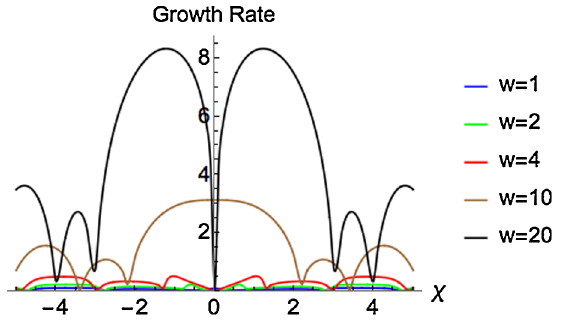
FIG. 8. Same as Fig. 7, but gT ¼ 10 .